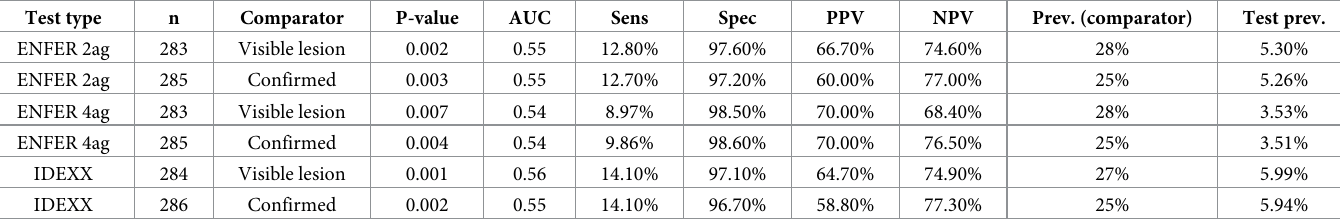
Table 2. The relative performance of serological tests against statutory post-mortem diagnostic techniques. Test